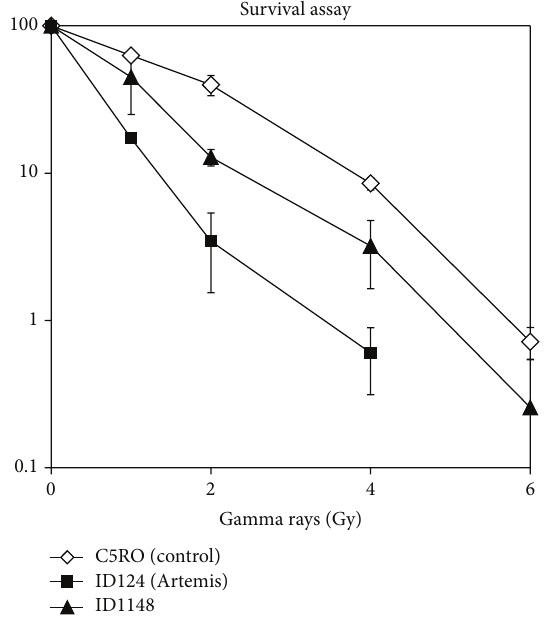
Figure 2: Radiosensitivity assay. Clonogenic survival assays with primary skin were performed as described in Noordzij et al., Blood 2003 [5]. In short, primary skin fibroblasts in exponential growth were trypsinized, and 1000–2,000 cells (10,000–20,000 cells for the highest doses) were seeded into 10 cm plastic dishes (2 dishes per dose) and irradiated at room temperature with 0, 1,2,4 or 6 Gy. After 12–14 days, the cells were rinsed with 0.9% NaCl and stained with 0.25% methylene blue for survival assessment. Two independent survival experiments were